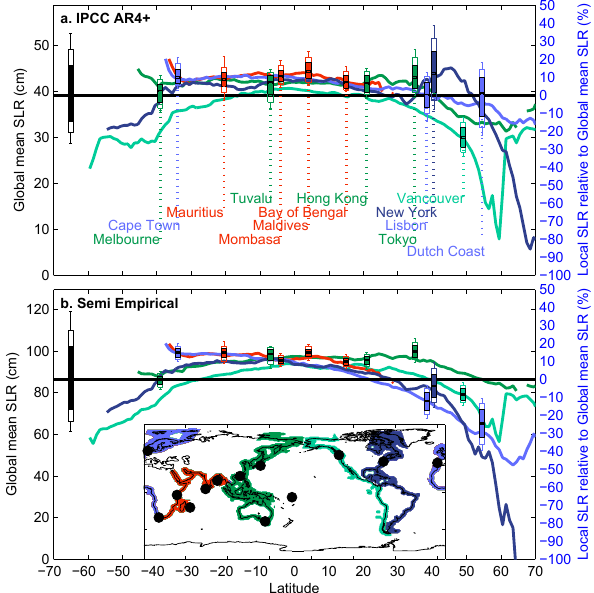
Fig. 9. Projected total sea level rise along world coastlines. Coloured lines show regional sea level projections, averaged over coastal areas ( < 300km from land), and for various ocean basins (see inlet for coastlines). Global mean SLR (cm) is indicated by a horizontal black bar on the left for each scenario, with 50, 67 and 80% uncertainty ranges. Particular locations are also shown (black dots on the inlet map, and vertical dashed lines). The uncertainty ranges for these only describe the relative deviation from the global mean (%), to highlight uncertainty in regional fingerprints. The to- tal uncertainty in regional sea level (shown in Fig. S5 in the Supple- ment for all RCP scenarios) is a combination of local (right y-axis) and global (left y-axis) sea level